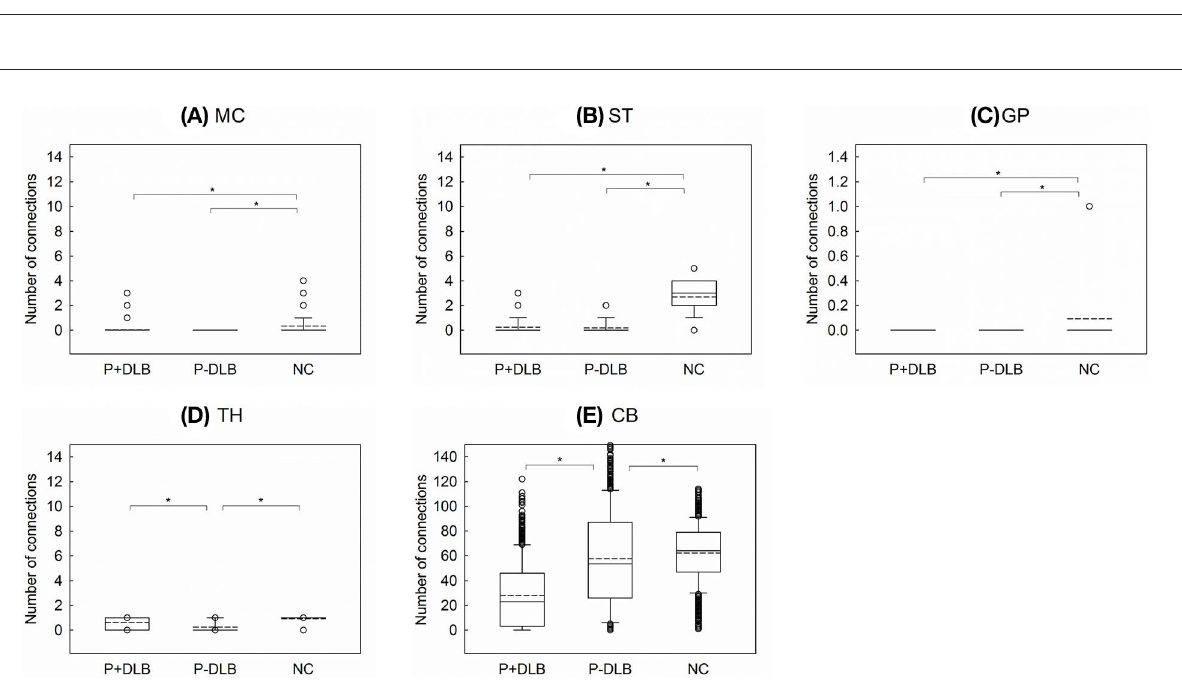
FIGURE3 Comparison of the number of intra-regional connections among P + DLB, P-DLB, and NC groups. Box plots of the mean number of connections between (A) MC, (B) ST, (C) GP, (D) TH, and (E) CB. The solid lines represent the median value and the dashed lines represent the mean value. * indicate significantly different group means at p < 0.001. P + DLB, dementia with Lewy bodies with parkinsonism; P-DLB, dementia with Lewy bodies without parkinsonism; NC, normal controls; MC, motor cortex; ST, striatum; GP, globus pallidus; TH, thalamus; CB,